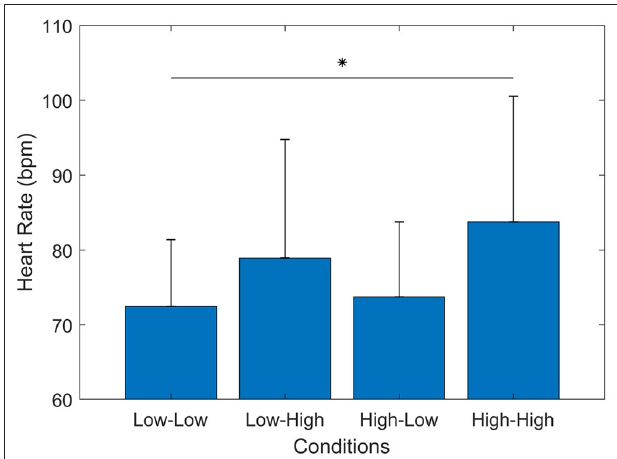
FIGURE 5 | Subjects’ heart rate (HR) in beats per minute (bpm). The bar graph represents the mean and the standard deviation of participants’ HR during the four experimental conditions. The Wilcoxon test showed a significant increase between High-High and Low-Low ( p = 0.003) conditions. ∗ p < 0.0083.